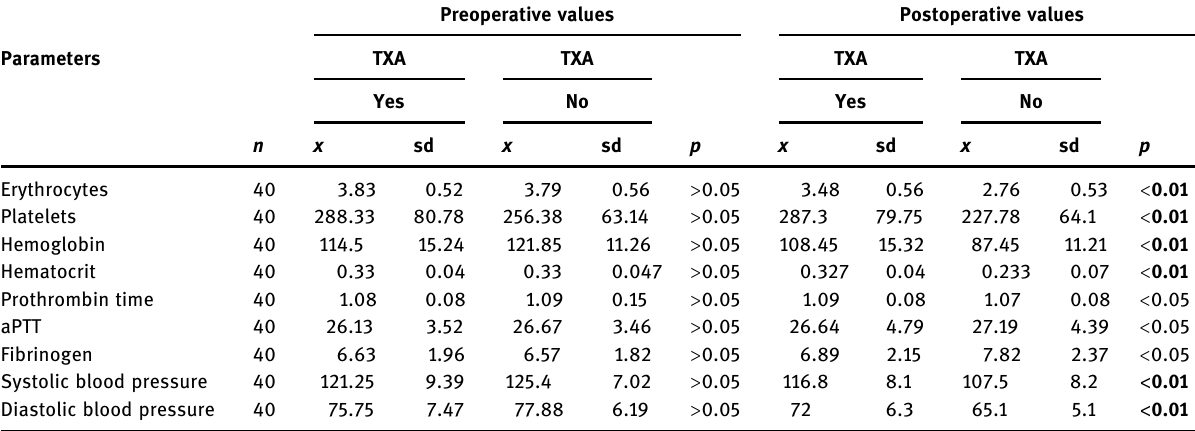
Table 1: Preoperative and postoperative values of the basic laboratory parameters in relation to the use of TXA